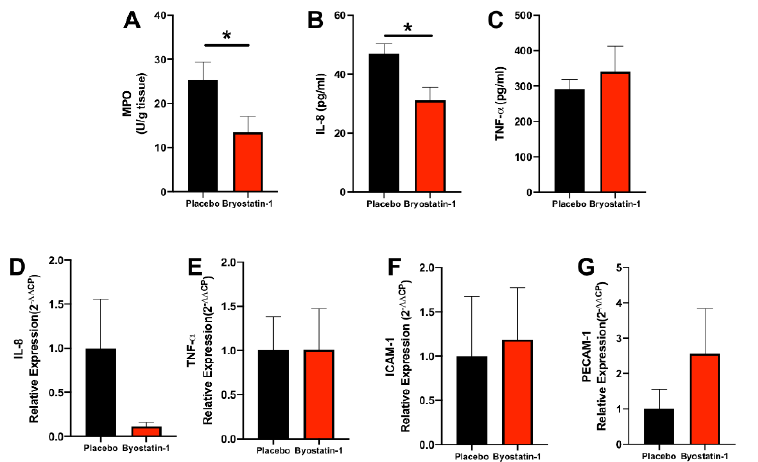
Figure 6. Bryostatin-1 attenuates neutrophil transmigration in renal autografts. All analyses were conducted eight hours after reperfusion in a porcine model of renal autotransplantation with graft- specific treatment with placebo or Bryostatin-1 during 20-h static cold storage of the renal autografts. ( A ) Myeloperoxidase (MPO) activity (in units per gram renal tissue) in renal autografts was measured as an index for tissue neutrophil content and was significantly reduced in Bryostatin-1 treated renal autografts. ( B ) Systemic protein concentration (pg/mg) of interleukin-8 (IL-8) was significantly reduced in Bryostatin-1 treated animals, while ( C ) protein concentration (pg/mg) of tumor necrosis factor alpha (TNF- α ) was comparable in placebo and Bryostatin-1 groups. To correlate systemic protein levels with local tissue changes, gene expression of ( D ) IL-8 and ( E ) TNF- α was analyzed in renal biopsies. Gene expression of cellular adhesion molecules (platelet endothelial cell adhesion molecule-1 (PECAM-1) ( F ) and intercellular adhesion molecule 1 (ICAM-1) ( G )) was tested and found to be comparable between groups. All data are presented as mean values ± SEM from 6 (placebo) or 7 (Bryostatin-1) individually analyzed animals per group. Data were analyzed with Student’s t -test, and significance is indicated by the following symbol: * p < 0.05 versus placebo.